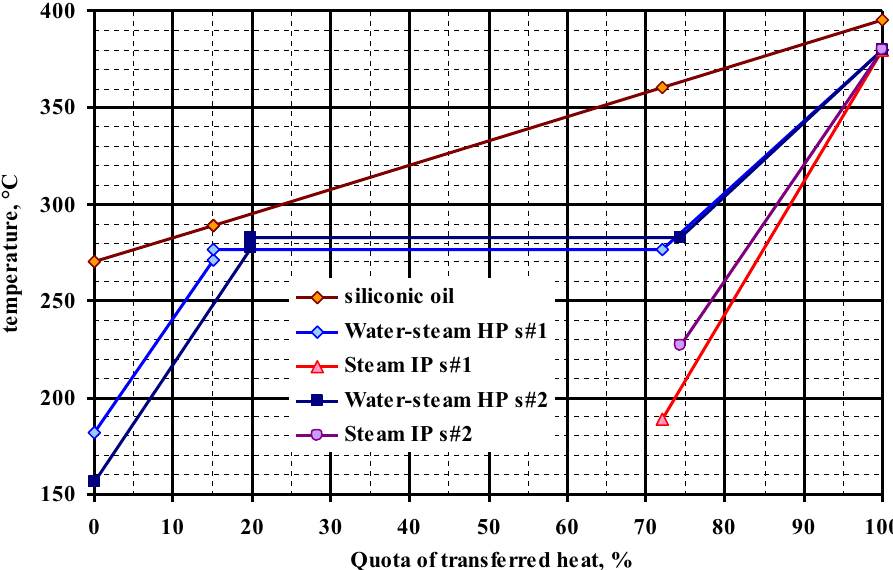
Fig. 4. The t-q heat transfer diagram in SG for the two